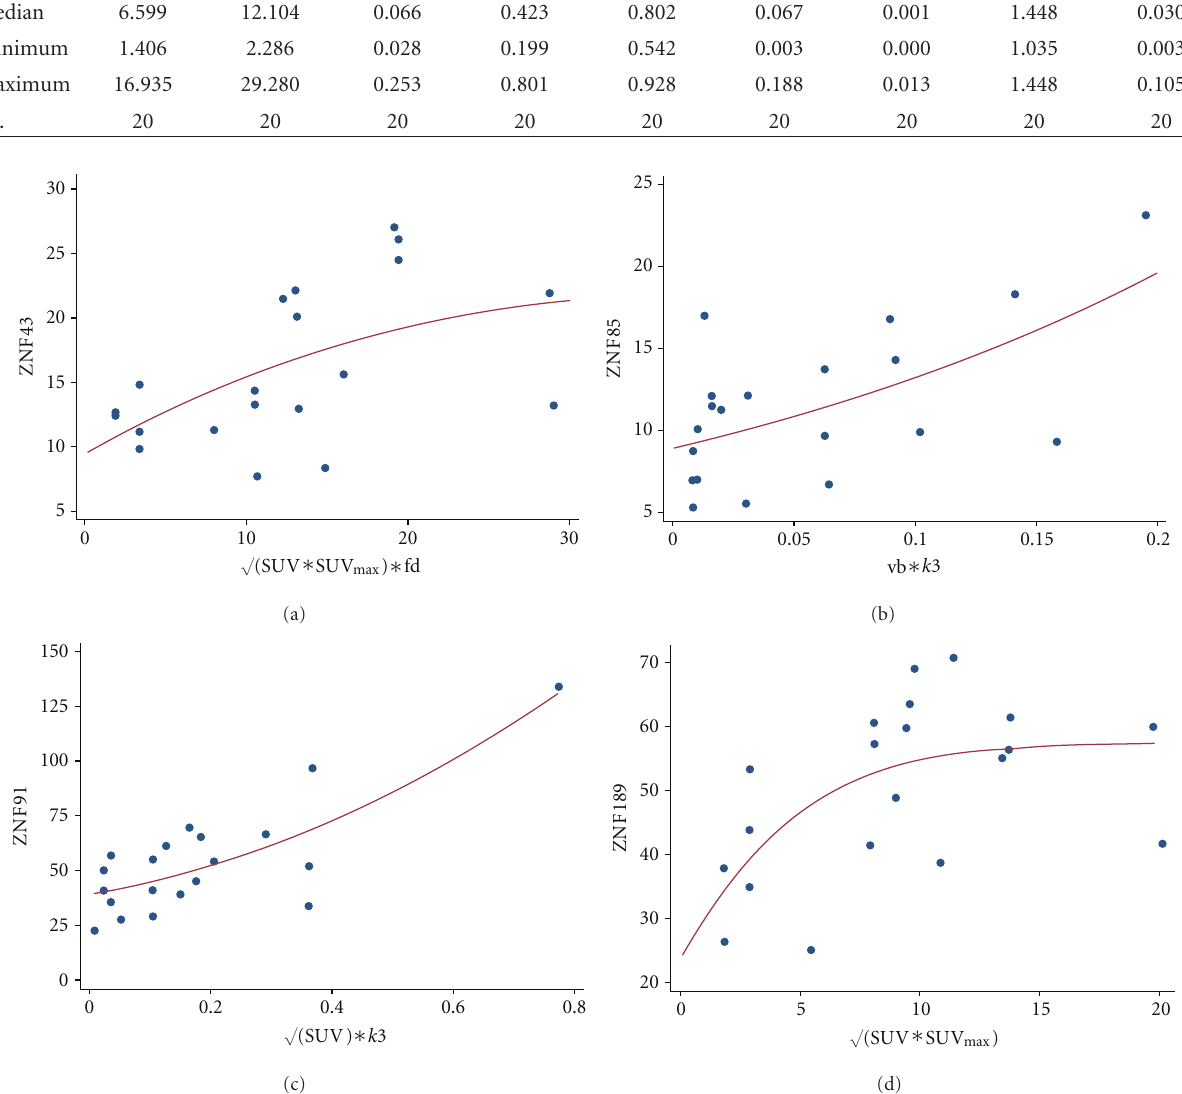
Figure 1: Correlations and nonlinear regression functions of PET parameters, obtained from the dynamic studies, and gene expression data.